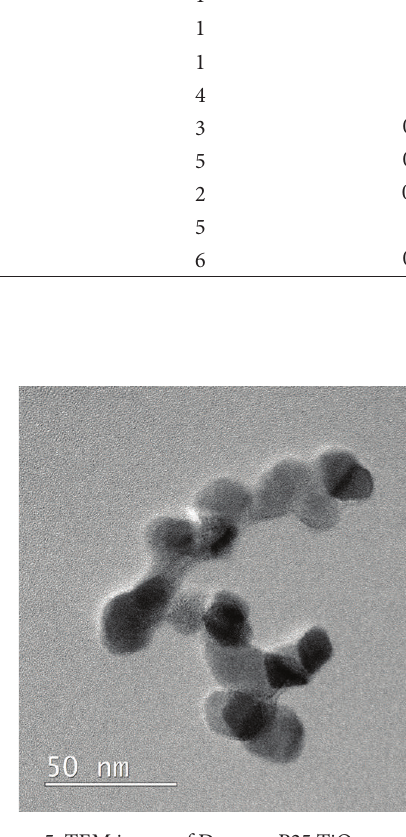
Figure 5: TEM image of Degussa P25 TiO 2